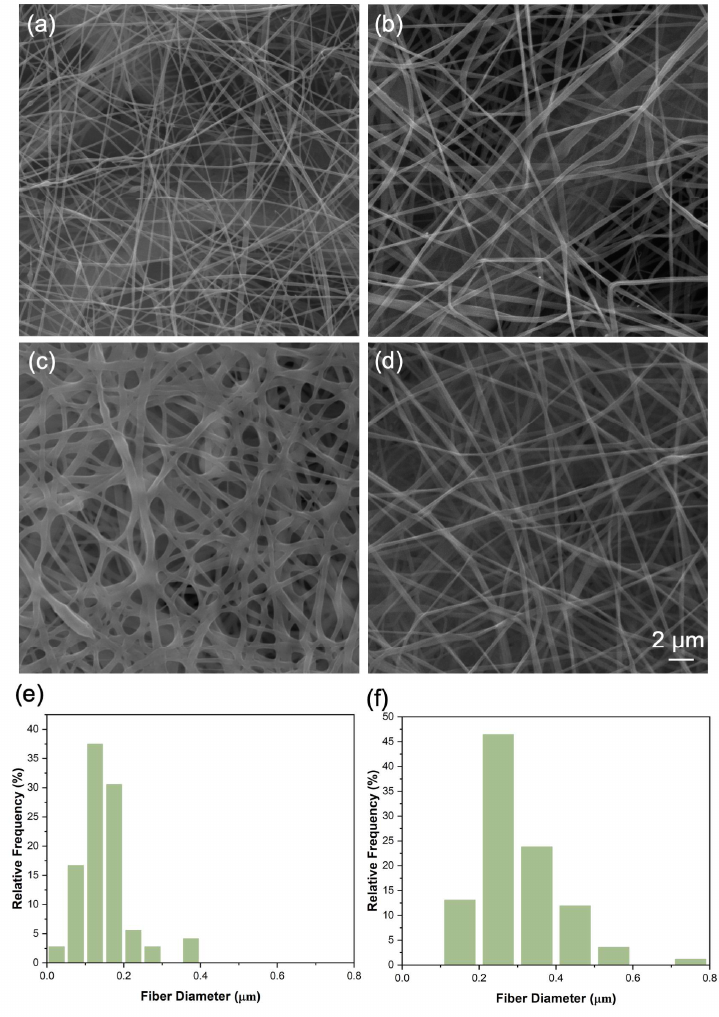
Figure 3. ( a ) SEM uncrosslinked zein fiber, ( b ) SEM of crosslinked zein fibers, ( c ) SEM of uncrosslinked zein fiber exposed to moisture for 60 min, ( d ) SEM of crosslinked zein fiber exposed to moisture for 60 min exposed to moisture (magnification 8000 × applied under SEM), ( e ) uncrosslinked zein fiber diameter distribution, ( f ) crosslinked zein fiber diameter distribution.